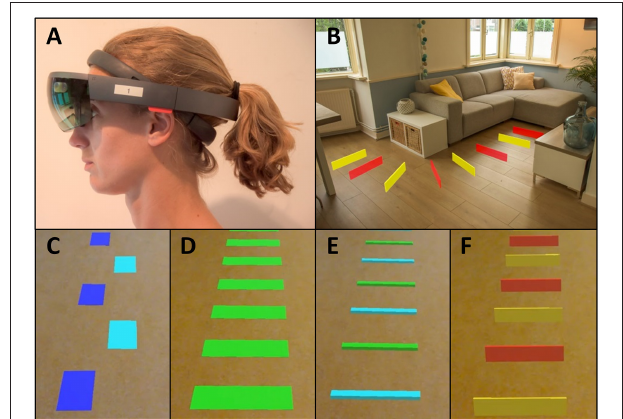
FIGURE 1 | Mixed-reality wearable headset (Microsoft HoloLens 1) (A) , with holographic visual cues of Holocue in a home environment (B) and a selection of different types of action-relevant holographic visual cues of Holocue in the form of 2D stepping stones (C) , 2D zebra stripes (D) , 3D beams (E) , and 3D hurdles (F)